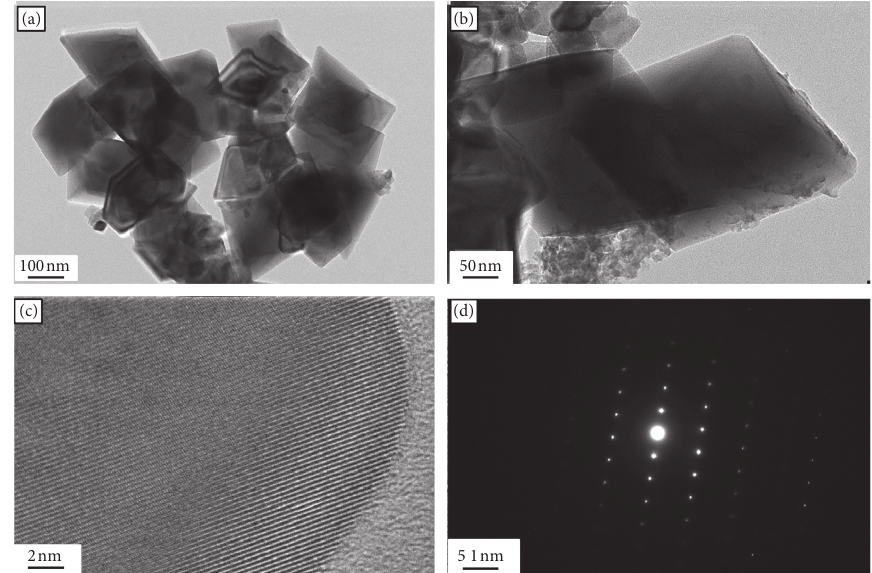
Figure 4: TEM images of YVO � 12.0, (b) pH � 13.0 and HRTEM image (c) and SAED (d) of crystals produced 4 crystals produced at (a) pH at pH � 13.0 through hydrothermal